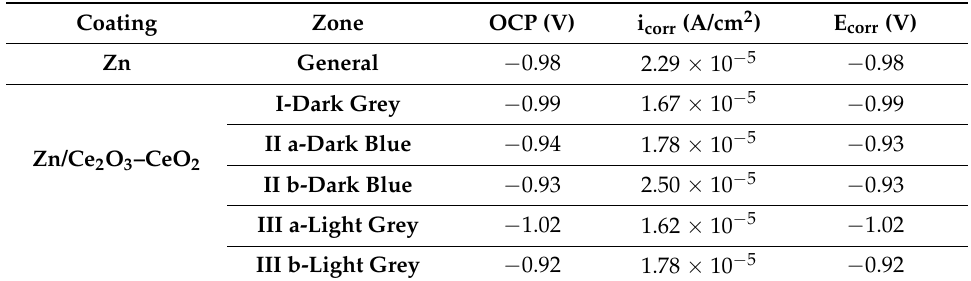
Figure 8. Cathodic polarization curves performed after 24 h of immersion in 0.05 M NaCl for each of the differentiated areas—dark gray, dark blue, and light gray. Table 2. Corrosion rate values (icorr) and corrosion potential values (Ecorr) obtained from polarisation curves.